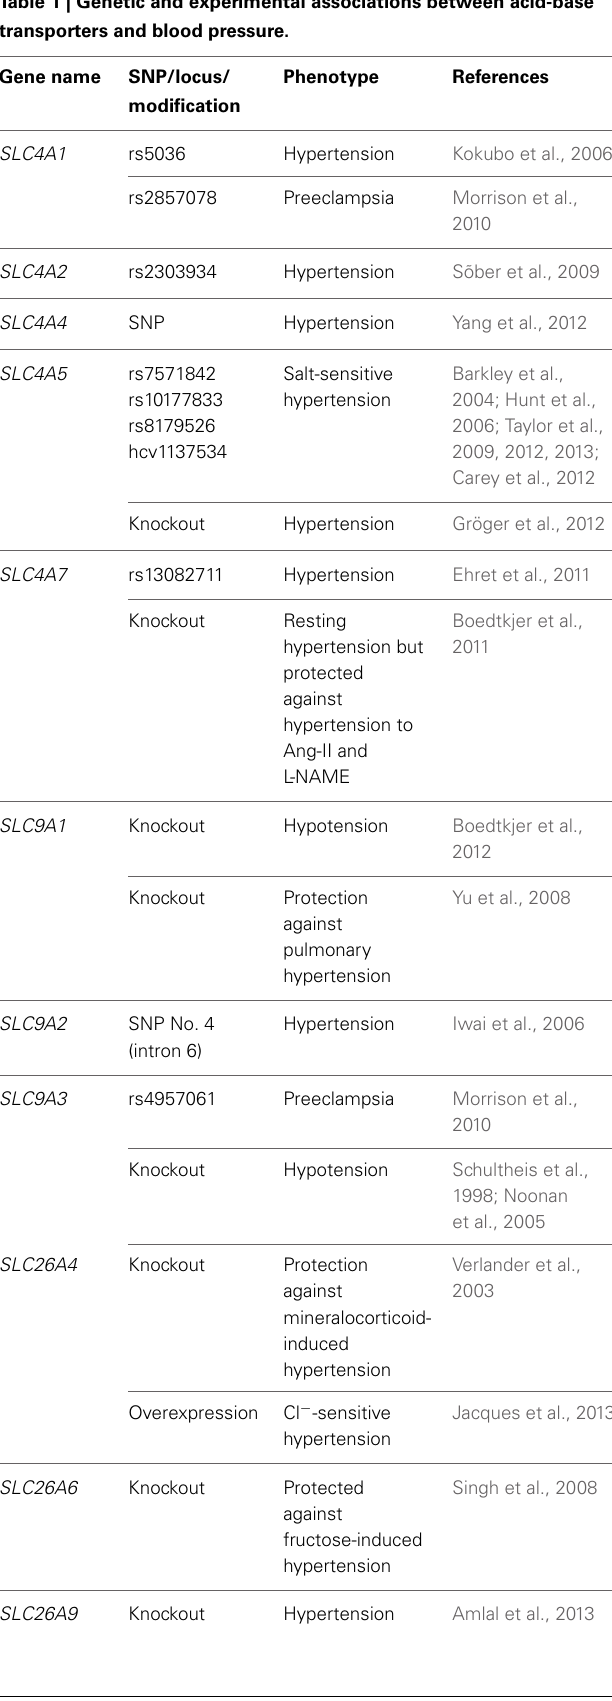
Table 1 | Genetic and experimental associations between acid-base transporters and blood